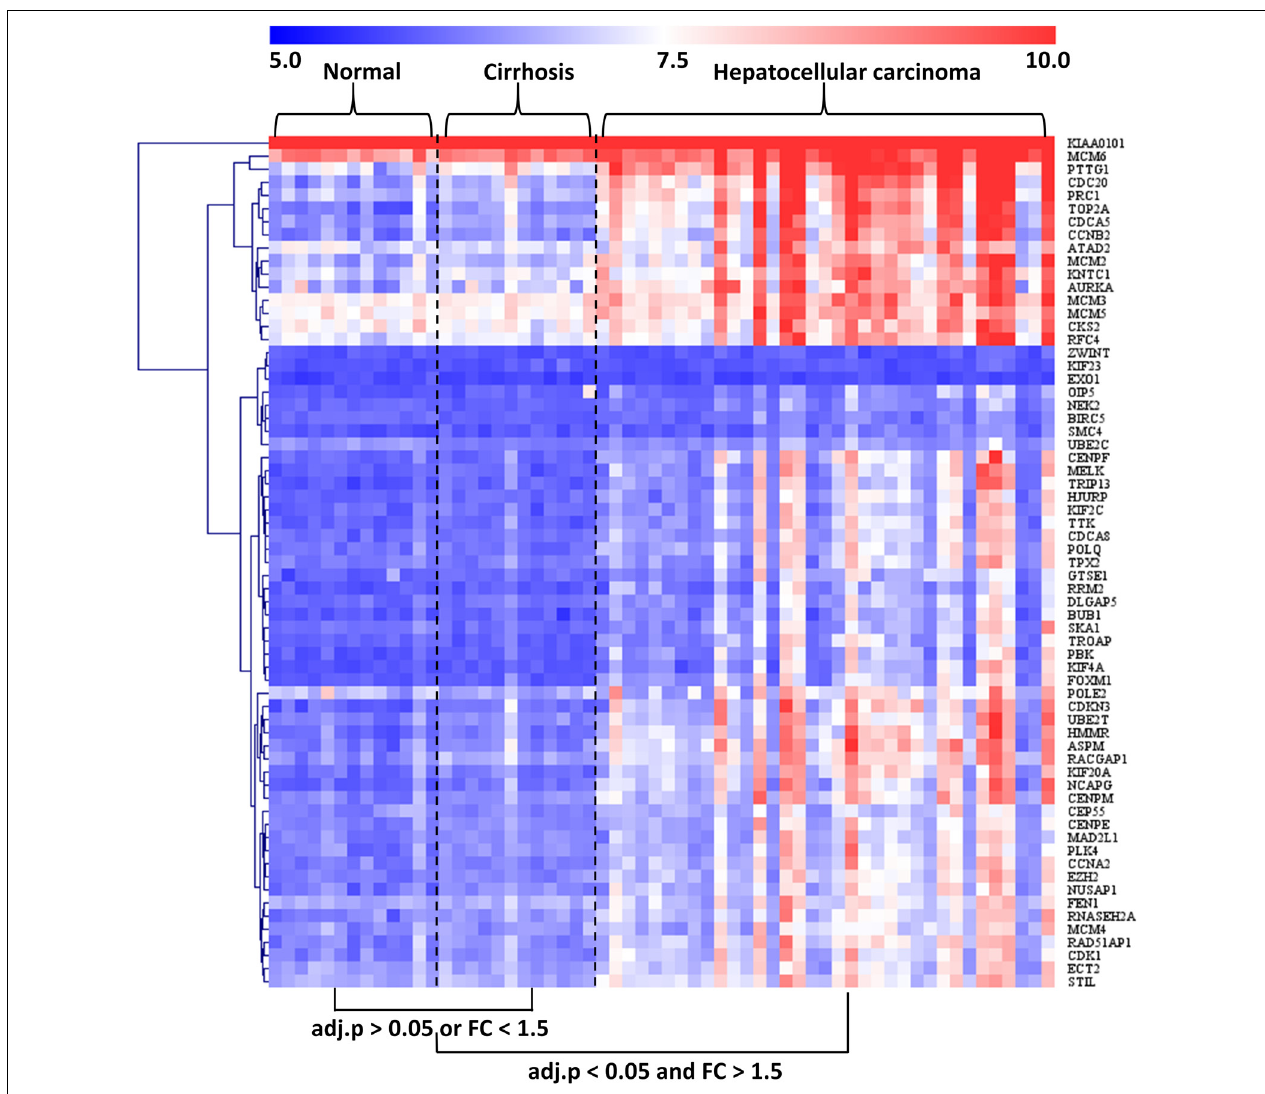
FIGURE 5 | Heatmap of modular gene expression in normal, cirrhotic, and HCC livers. GSE89377 dataset contained 13, 12, and 35 normal, cirrhosis, and HCC subjects, respectively. Modular gene expression in GSE89377 was normalized by antilog-transformed RMA value. Heatmap of modular gene expression was generated by MeV software. Differential gene expression analysis between the two groups was performed using GEO2R. FC represents fold-change. Red indicates high expression and blue signifies low